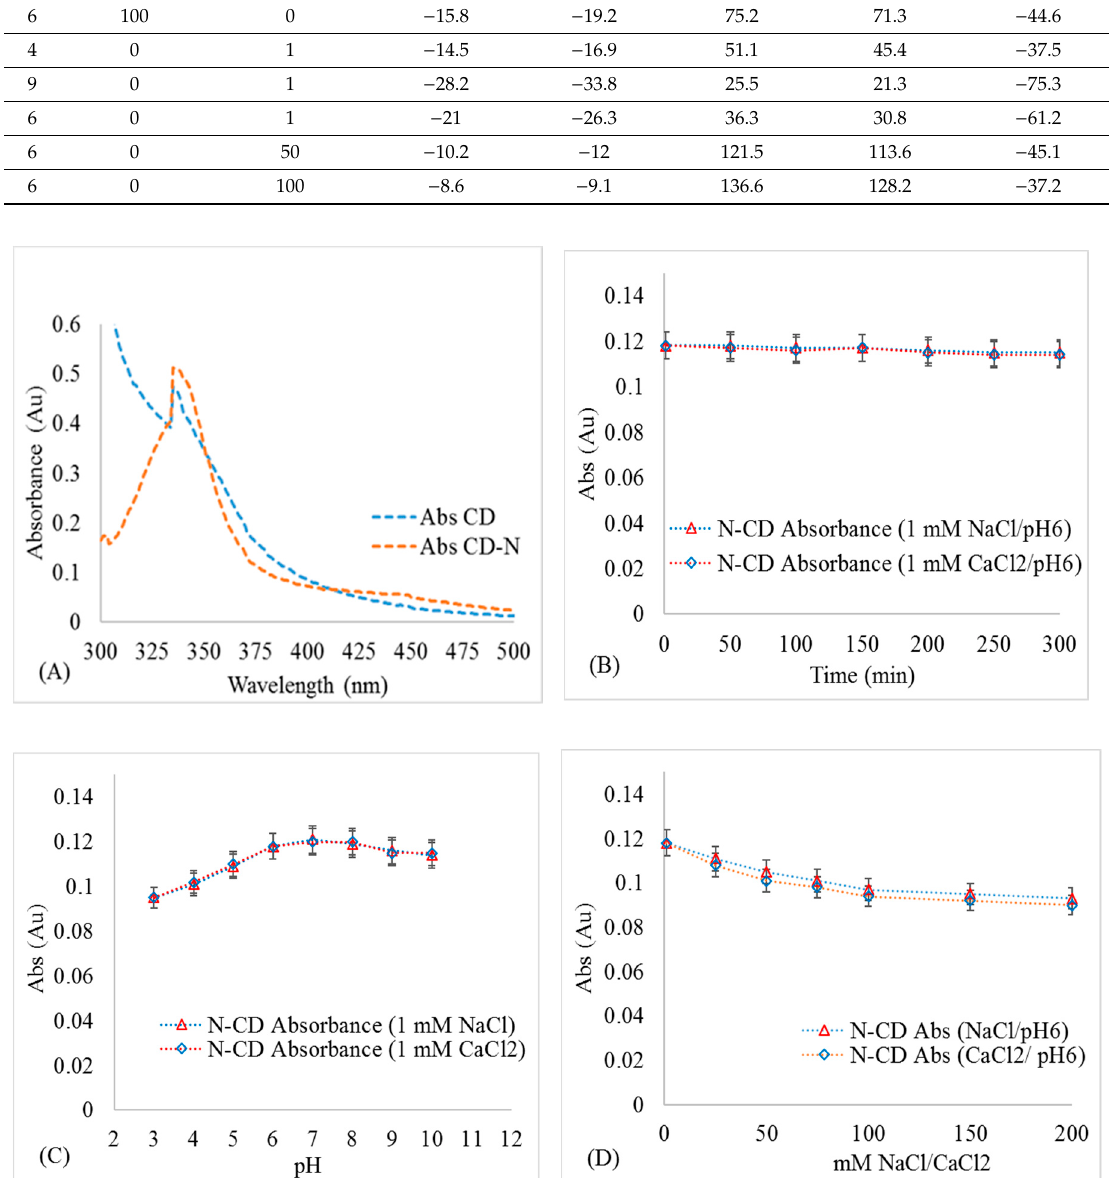
Figure 2. Stability of 50 mg L − 1 N-CD: ( A ) UV-vis spectra of N-CD / CD at 200 mg L − 1 . ( B ) Absorbance at 335 nm at different times after synthesis; ( C ) change in the absorbance at 335 nm at different pH; and ( D ) at different IS.